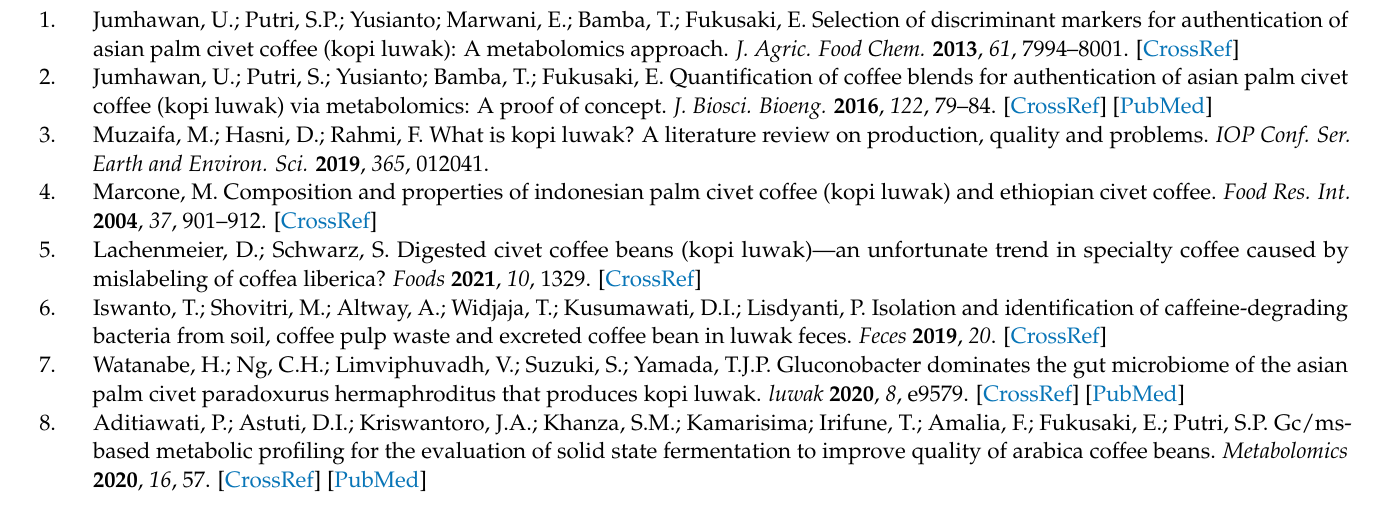
(F) HMBC NMR spectra for the assignment of n-methylpyridinium. All assignment details are listed in Table 1. Figure S2: Percentile proportion of metabolite groups in different coffee samples as identified by SPME/GC-MS; Figure S3: (A) OPLS-DA model score plot of Luwak coffee versus roasted coffee. (B) Permutation analysis to validate the OPLS-DA model score plot of Luwak coffee versus roasted coffee. (C) OPLS-DA model S-plot of Luwak coffee versus roasted